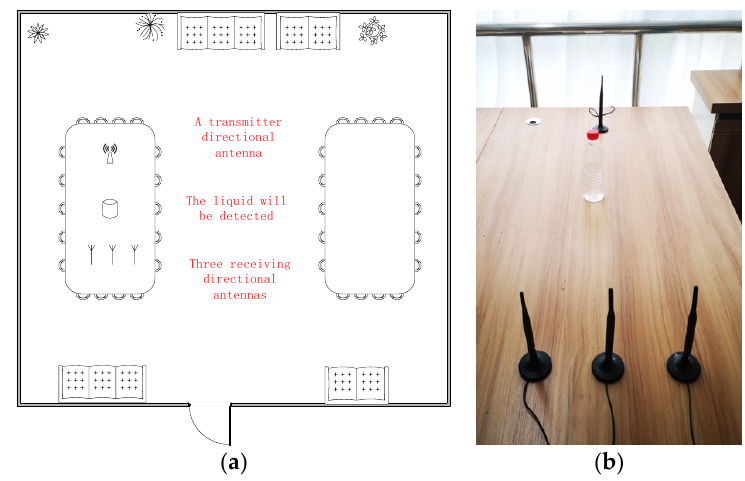
Figure 1. ( a ) Experimental scenario; ( b ) The actual scene.